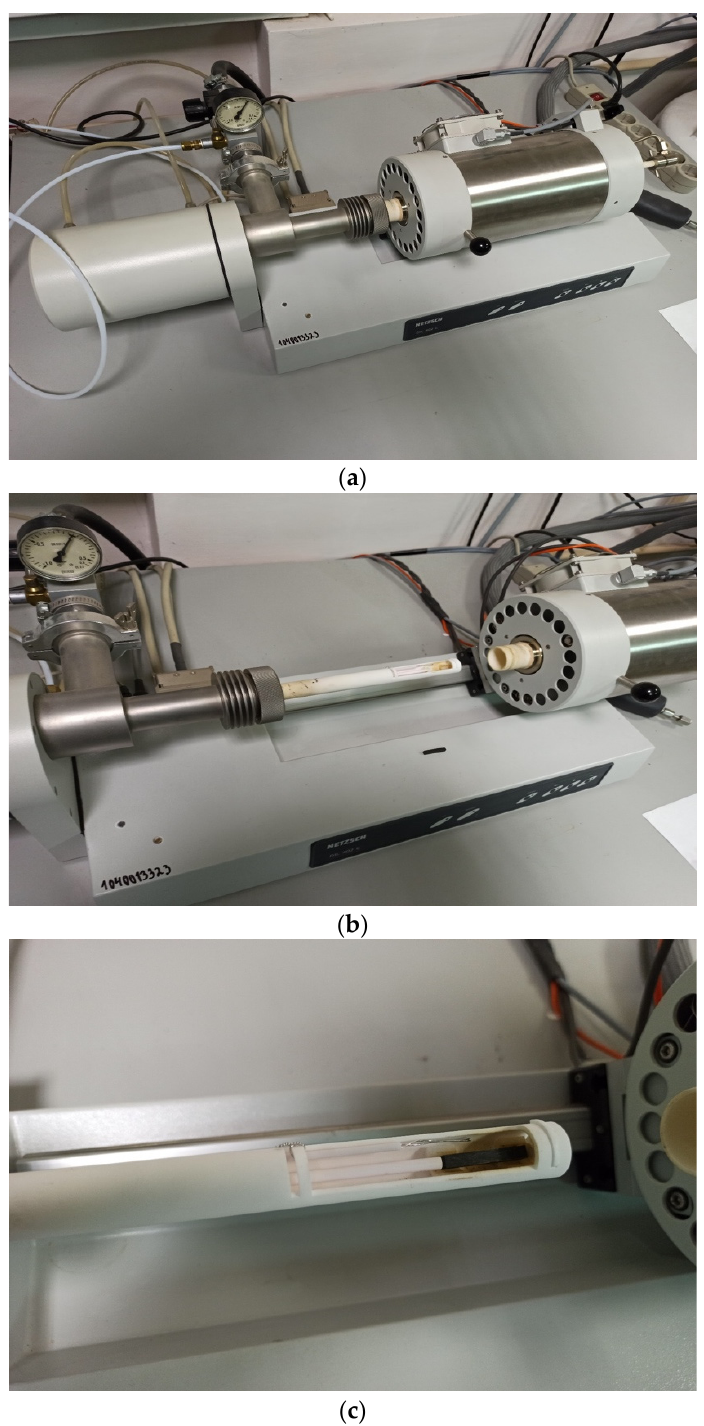
Figure 2. Dilatometer Netzsch DIL 402 C: ( а ) in process; ( b ) opened; ( c ) with sample (brown).